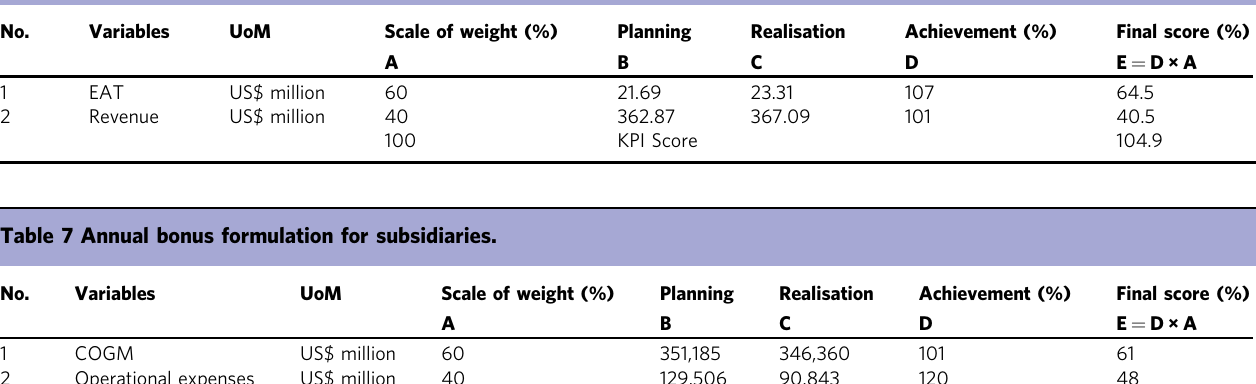
Table 6 Annual bonus formulation for